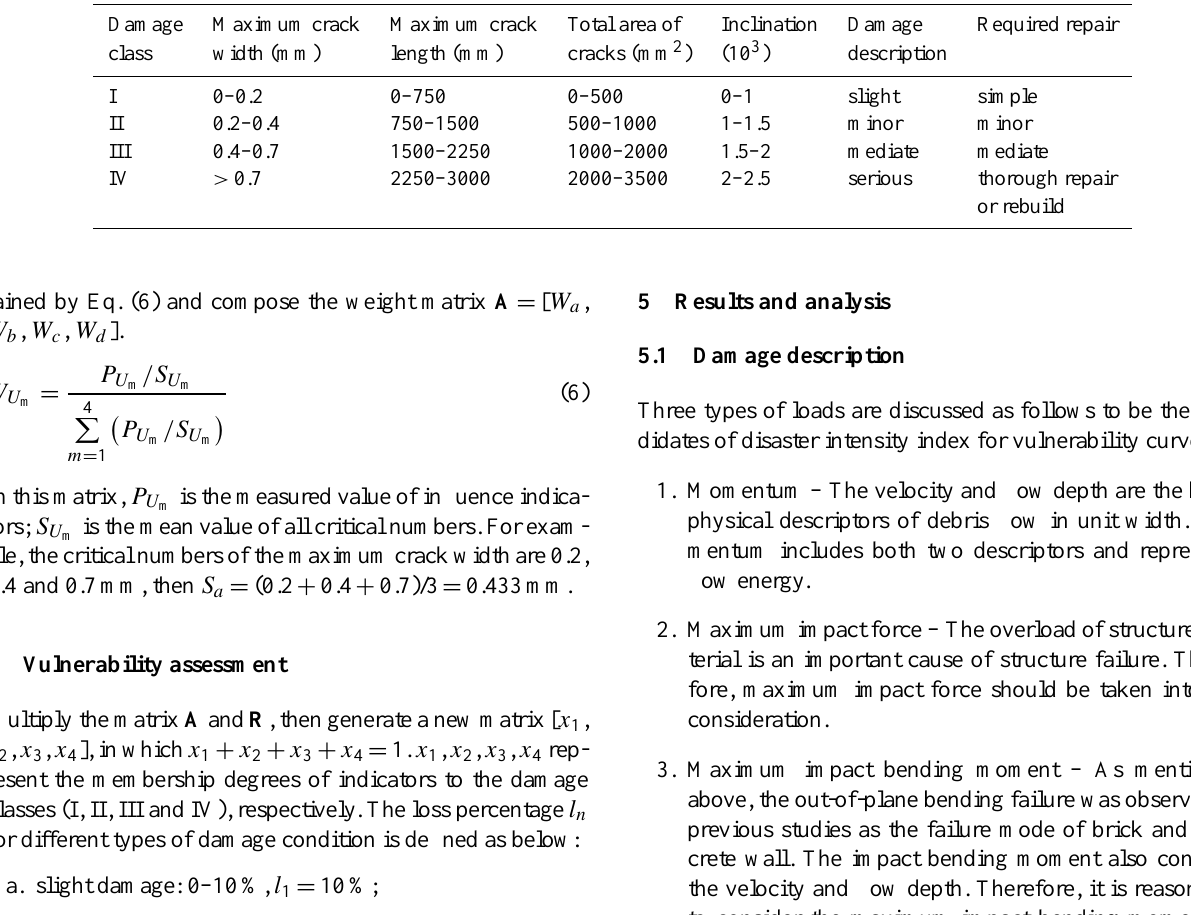
Table 2. Failure criterion for the load-bearing wall impacted by a single iron